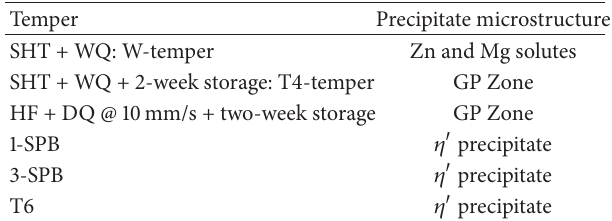
Table 3: Condition and precipitate microstructure for AW-7921 sheet for the various tempers, as discerned from the DSC measure- ments.